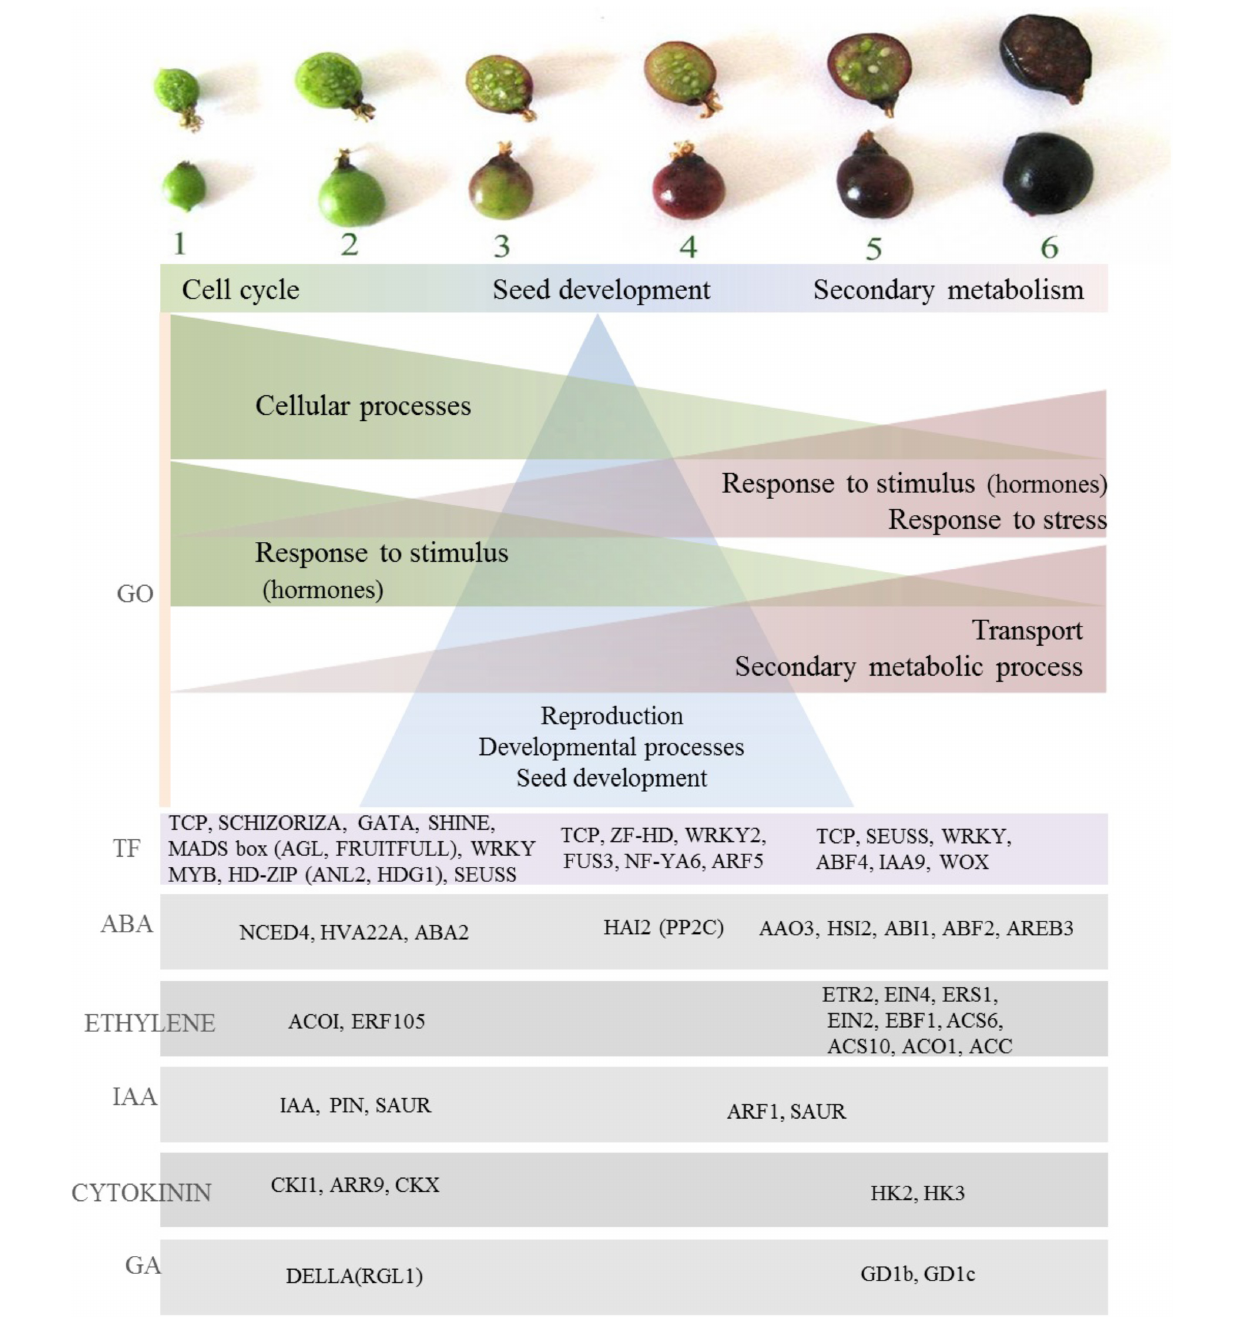
FIGURE 8 | Overview of gene expression associated with fruit development in blackcurrant. Gene ontology (GO) term enrichment highlights specific processes associated with different stages of fruit development. An analysis of transcript abundance at different stages of development highlights the role of specific transcription factors and various transcripts associated with different hormonal